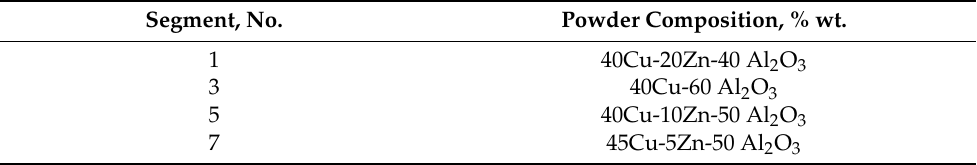
Figure 2. Simulation of local wear of the overhead wire segments. Designing stage ( a , b ) and assembled octagon with contact wire with worn areas 1, 3, 5, 7 ( c , d ). Table 1. Compositions of samples of restored contact wire segments for friction testing with a current